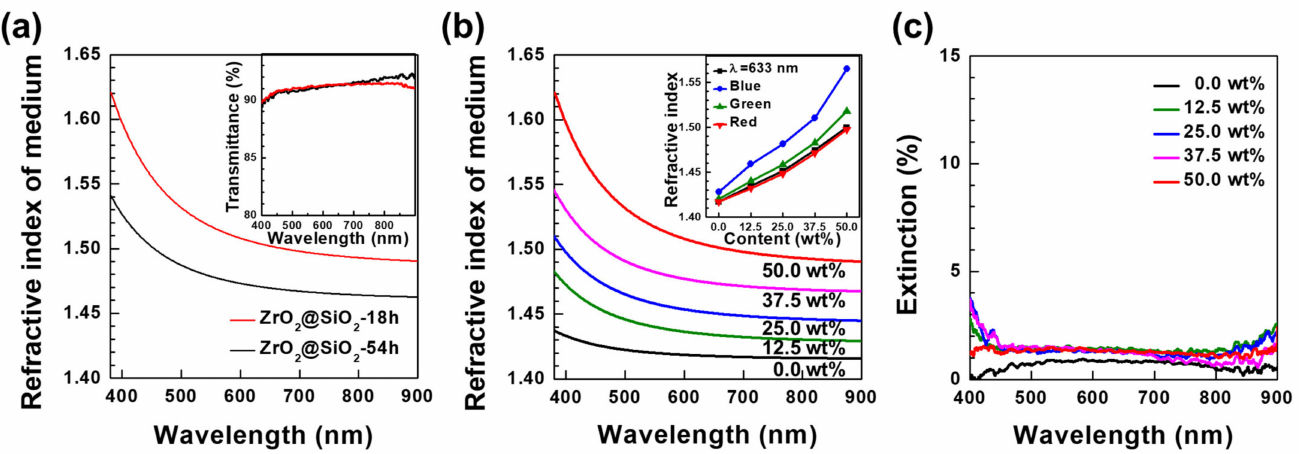
Figure 6. ( a ) Refractive index dispersions of (red) ZrO 2 @SiO 2 -18h-PDMS and (black) ZrO 2 @SiO 2 -54h- PDMS nanocomposite films. Films were prepared with particle contents of 50 wt%. The inset shows the transmittance spectra of the corresponding nanocomposite films. ( b ) Refractive index dispersions of ZrO 2 @SiO 2 -18h-PDMS films with different NP contents (0.0 to 50.0 wt%). The inset shows the refractive indices (at (black) λ = 633 nm and RGB wavelengths selected according to the CIE 1931 color space (blue— λ = 436 nm, green— λ = 546 nm, and red— λ = 700 nm) of the corresponding nanocomposite films. ( c ) Extinction spectra of the corresponding nanocomposite films. Finally, the refractive index dispersions for ZrO 2 @SiO 2 -18h-PDMS were measured at different NP contents of 0.0, 12.5, 25.0, 37.5, and 50.0 wt%, as shown in Figure 6b. The re- fractive indices of ZrO 2 @SiO 2 -18h-PDMS with different NP contents were represented at a wavelength of 633 nm and at RGB colors selected according to the CIE 1931 color space; red— λ = 700 nm, green— λ = 546 nm, and blue— λ = 436 nm (Figure 6b (inset), Table S2)